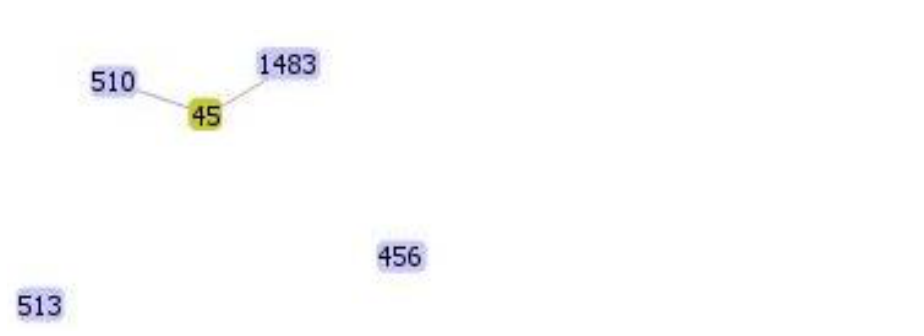
Figure 3. Cluster of the E. cloacae complex isolates carrying the bla KPC-2 gene generated with the goeBURST algorithm.